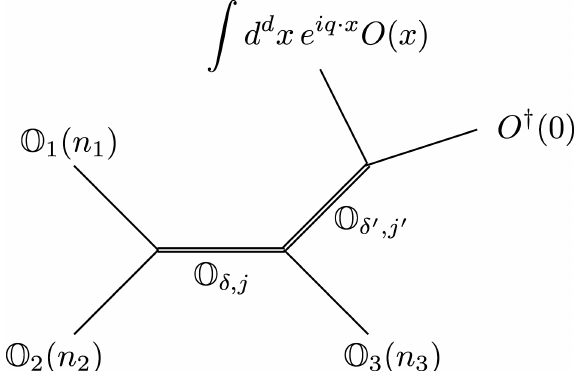
Figure 5. A schematic illustration of the sequential light-ray OPE used to analyze the three-point energy